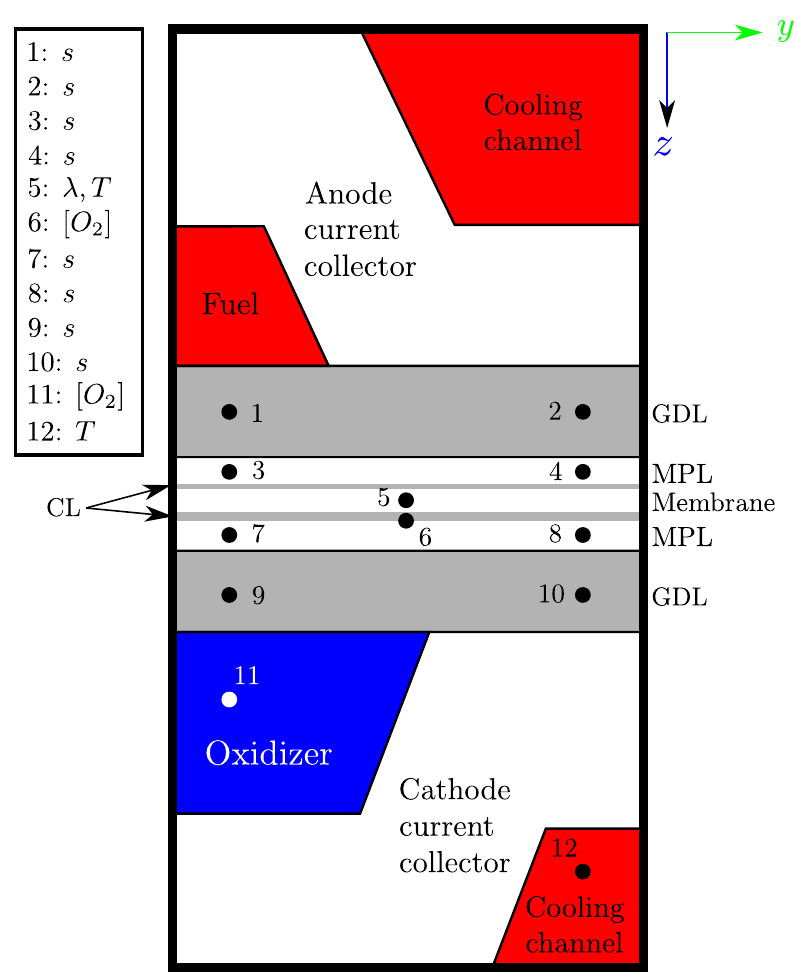
Figure 2. PEMFC cross-section plane showing the locations for the longitudinal axis evolution of variables. The legend indicates which variables are studied at each